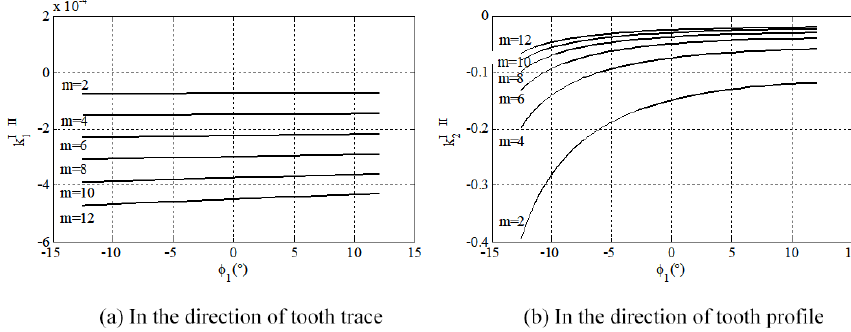
Figure 7. Effect of tooth module on induced normal curvature.